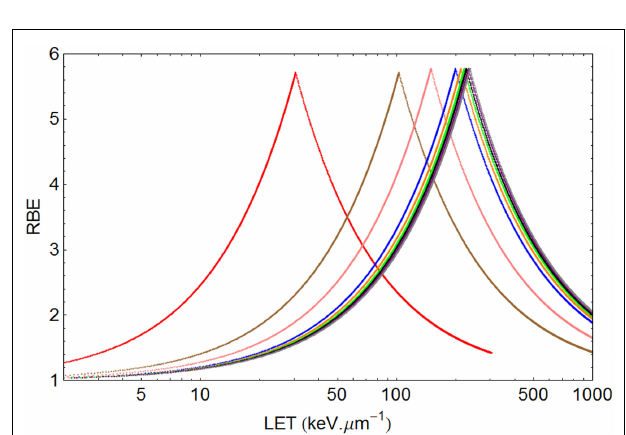
FIGURE 6 | Graphical displays of RBE and LET with unique turnover point positions for multi-ion data of Todd, assuming ααα === 0.14Gy (cid:0)(cid:0)(cid:0) 1 and βββ === 0.05Gy (cid:0)(cid:0)(cid:0) 2 for a dose of 1.5Gy . From left to right the ionic elements are shown as follows, with color code and LET U (rounded to nearest integer for values over 100) in parentheses: Deuterium (red, 30.5), Helium (brown, 103), Lithium (pink, 150), Boron (blue, 200), Carbon (orange, 213),